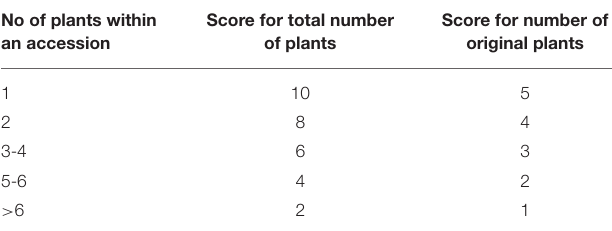
TABLE 1 | Score table for total number of plants and number of original plants in CICC collection. No of plants within Score for total number an accession of plants